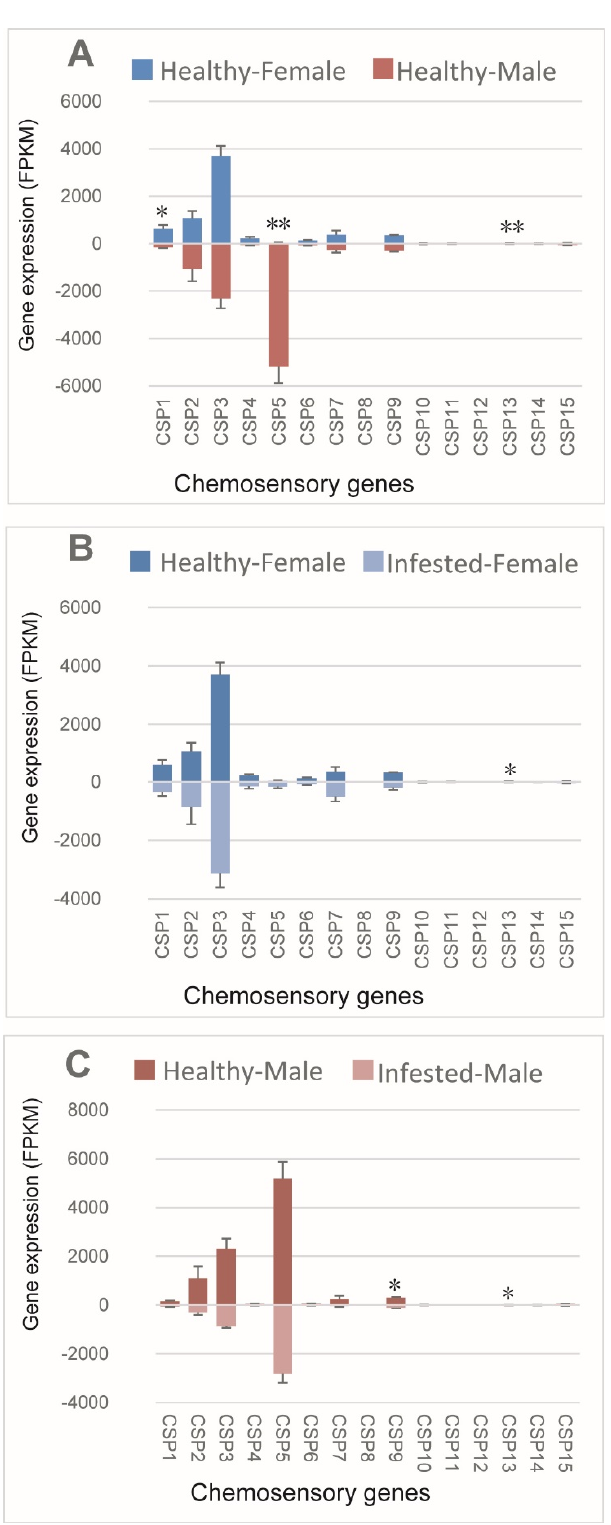
Figure 3. Expression patterns of chemosensory genes in healthy and B. xylophilus -infested M. saltuarius . ( A ) Differences between sexes of healthy M. saltuarius ; ( B ) Differences between healthy and infested female M. saltuarius ; ( C ) Differences between healthy and infested male M. saltuarius . Transcript levels are expressed as reads per kilobase of exon per million mapped reads (RPKM), and the expression data were shown as mean ± SE. The stars above each bar of figure indicate significant differences ( p < 0.05 * and p < 0.05